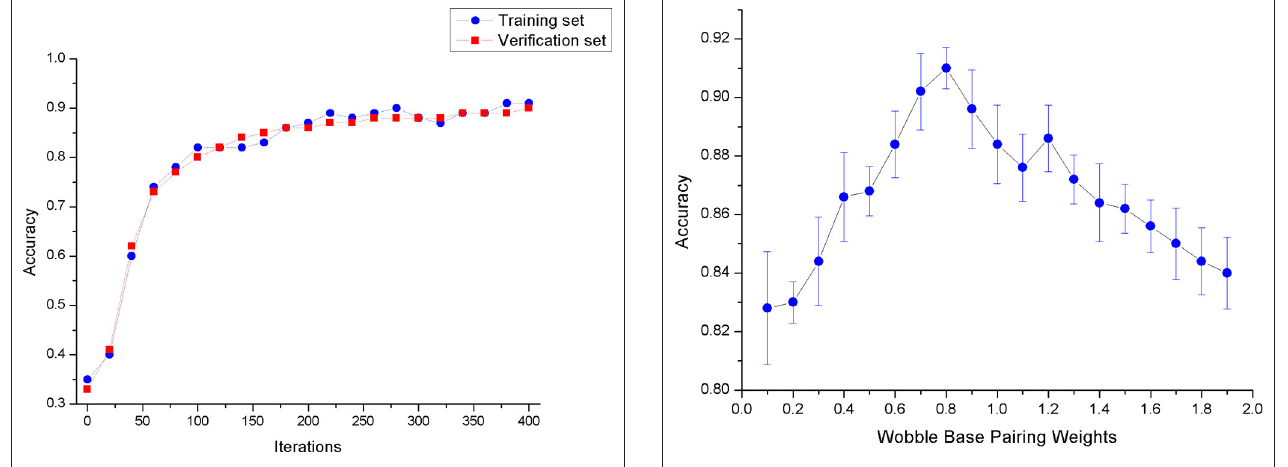
FIGURE 6 | The accuracy of the model in the training set and the validation set. method using a batch random gradient descent uses 256 data